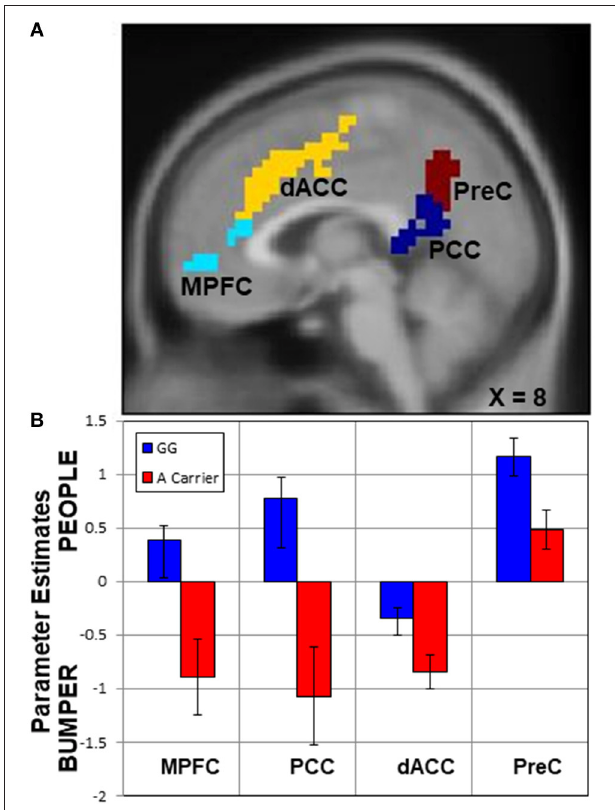
FIGURE 3 | Upper panel (A) , regions with activation differences based on SNP rs2254298. Two neural regions emerged from the whole-brain two-sample t -test comparing rs2254298GG subjects to rs2254298A subjects, the medial prefrontal cortex (MPFC, cyan) and the posterior cingulate cortex (PCC, blue). Two additional regions modulated by the task conditions also showed differences based on this SNP, the dorsal anterior cingulate (dACC, yellow) and the precuneus (PreC, maroon). In the lower panel (B) , means and standard errors of the parameter estimates for each region were extracted for each subject and averaged across each group. In all regions, the rs2254298A carriers have less modulation for the People relative to Bumper condition than the rs2254298GG